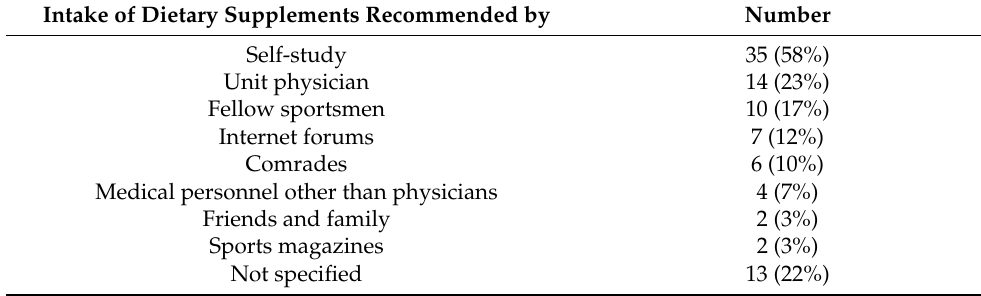
Table 3. Replies to the question of who recommended the intake of dietary supplements, multiple replies were possible, n = 60.